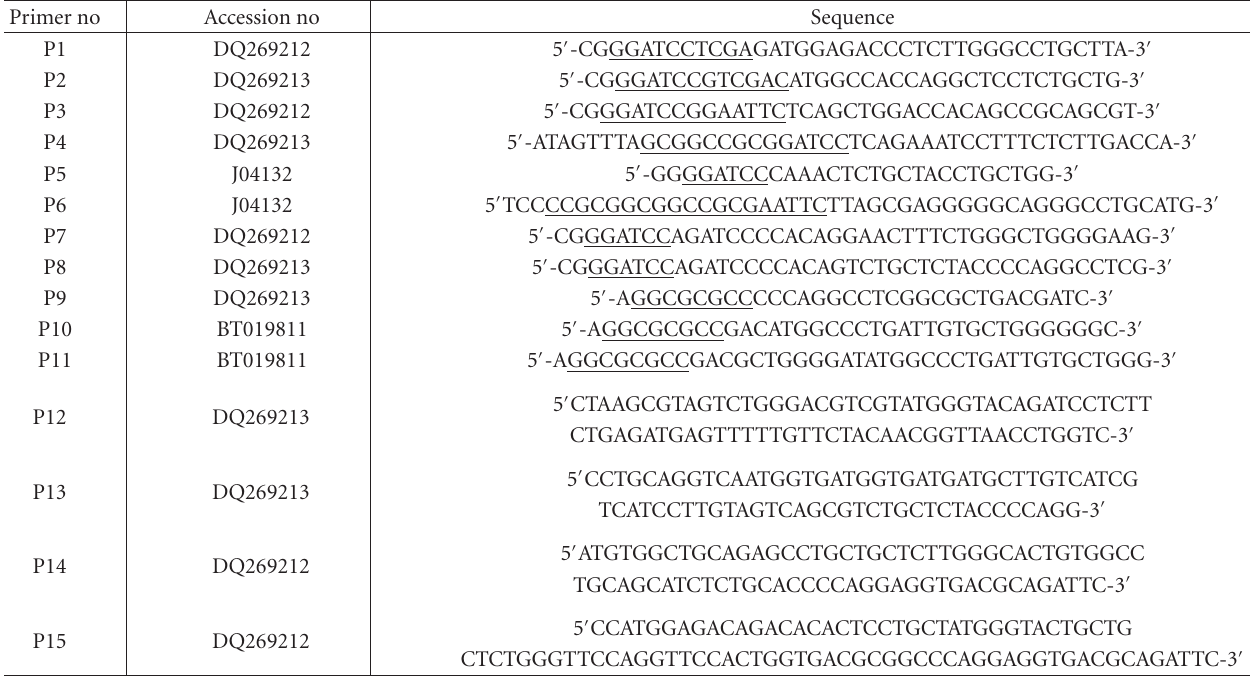
Table 1: Nucleotide sequences and restriction enzyme